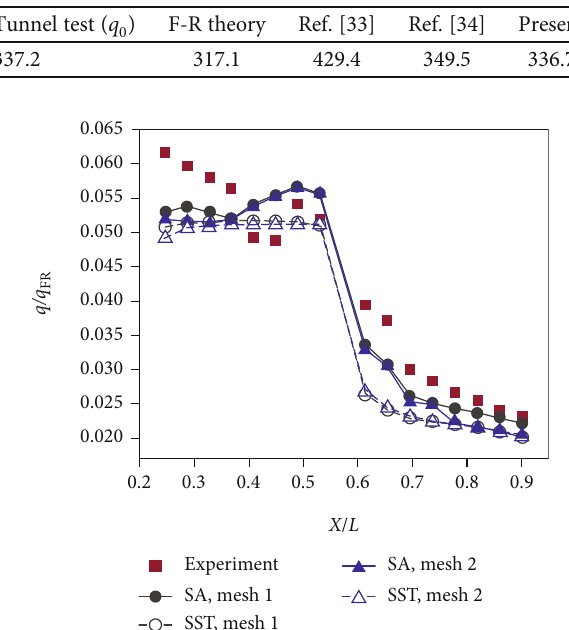
Table 3: Stagnation point heat fl ux ð kW/m 2 Þ .